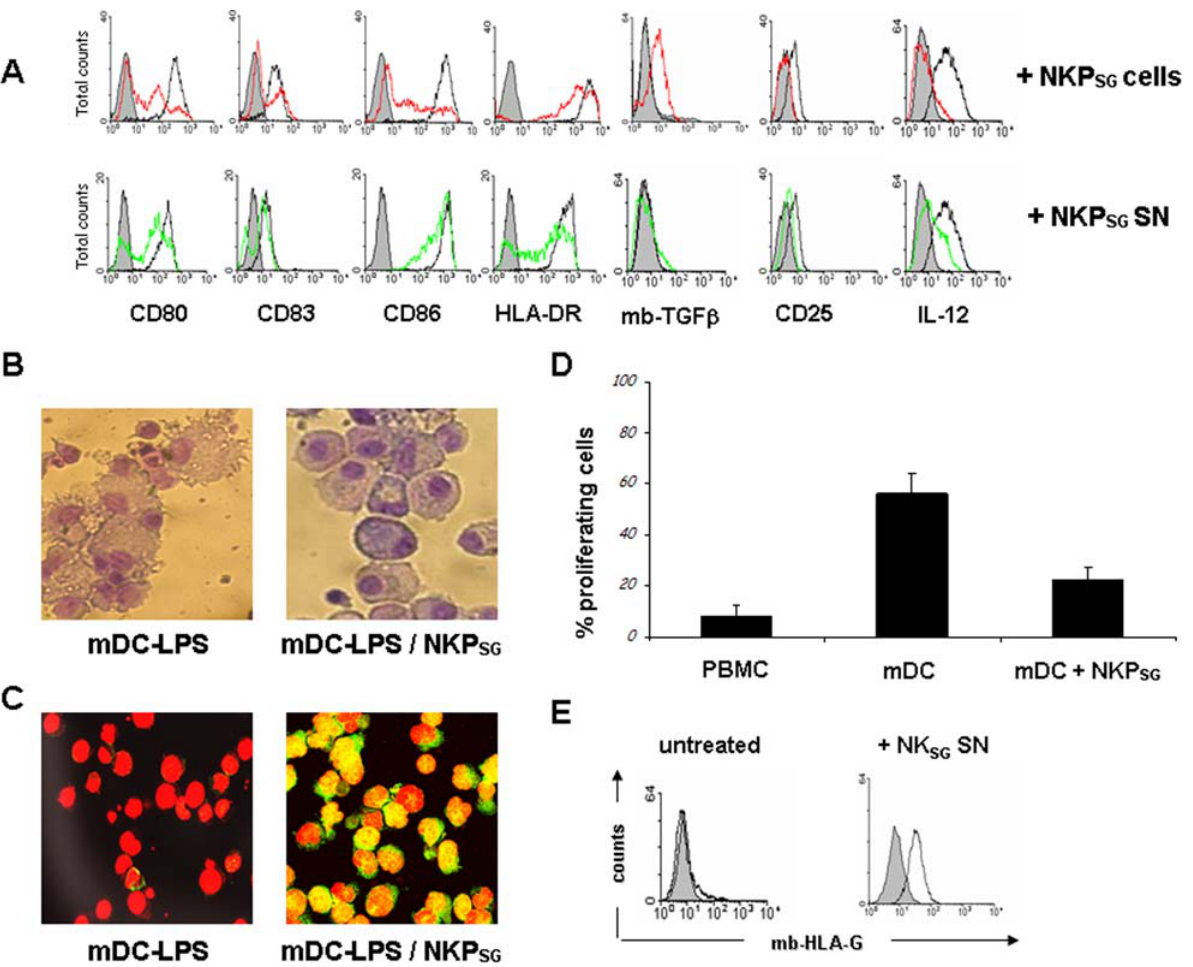
Figure 6. NKP SG cells display regulatory functions on the maturation of myeloid dendritic cells and PB-derived monocytes . (A) Flow cytometry show the modifications of the phenotype of mature myeloid dendritic cells (mDC, black lines), after co-culture of 3 weeks-old NKP SG cells (continuous red lines) or conditioned supernatants of NKP SG cells (green lines) . Control IgG1 (shadowed peaks). The data are representative of four separate experiments. The data are representative of four separate experiments. (B) RAL 555 staining shows the morphology of LPS matured myeloid DC before and after the co-culture with NKP SG cells (objective x40, NA=1). The data are representative of four separate experiments. mDC exhibit a dendritic morphology underlined by the presence of typical vacuoles and fillopodial extensions whereas causes the rapid reshaping represented by the appearance of healthy cells displaying the morphology of immature DC. (C) Nuclear localization of phospho-STAT3 (nuclear yellow staining) in six-days-old mDC before and after 1 hour of contact with NKP SG cells was analyzed by confocal microscopy. DC were fixed, permeabilized, and stained for phopho-STAT3 transcription factor (green). Nuclei were stained by propidium iodide (red). As negative controls, cells were incubated with rabbit IgG, the second reagent, and propidium iodide. The data are representative of three separate experiments. (D) Flow cytometric analysis of the proliferation potential in naı¨ve allogeneic PBMC following CFSE staining. The black columns represent the percentage of proliferating cells. The data are representative of three separate experiments. (E) Flow cytometric analysis of HLA-G molecules (continuous black line) on PB-derived monocytes treated or not with supernatant of NKP SG cells. Isotype control (shadowed peak). The data are representative of three separate experiments.